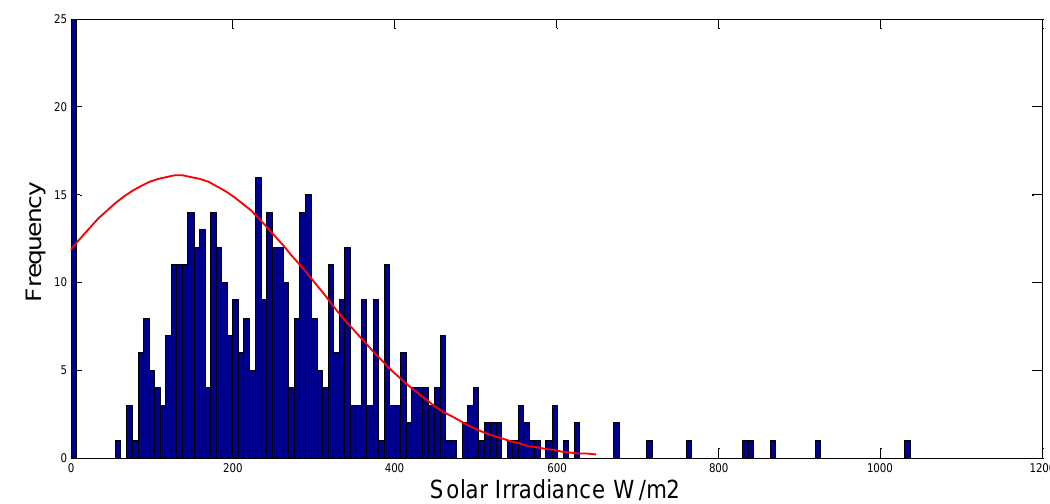
Figure 2. Solar irradiation scenarios for PV units (without zero irradiance).